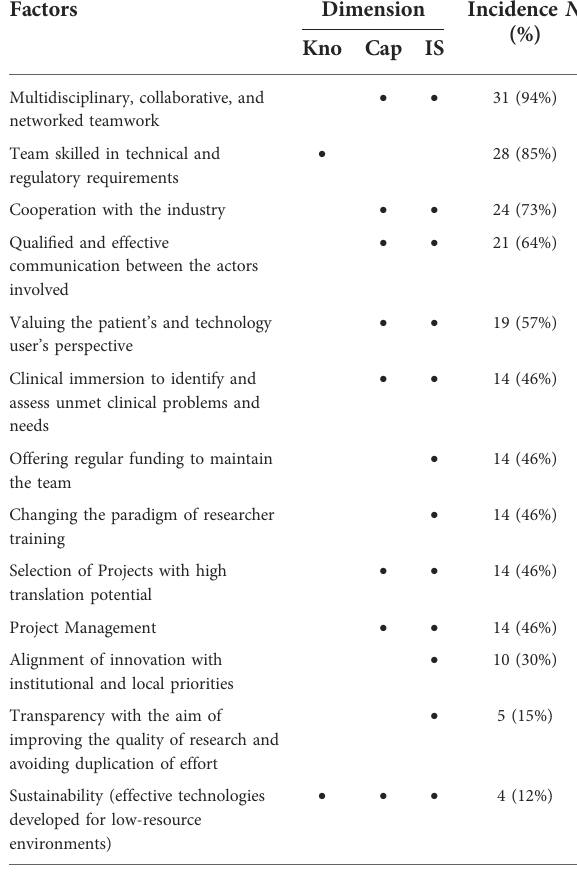
TABLE 4 Incidence of the barriers pointed out as determinants to be faced by academic laboratories in the implementation of translational research, from the analysis dimension.